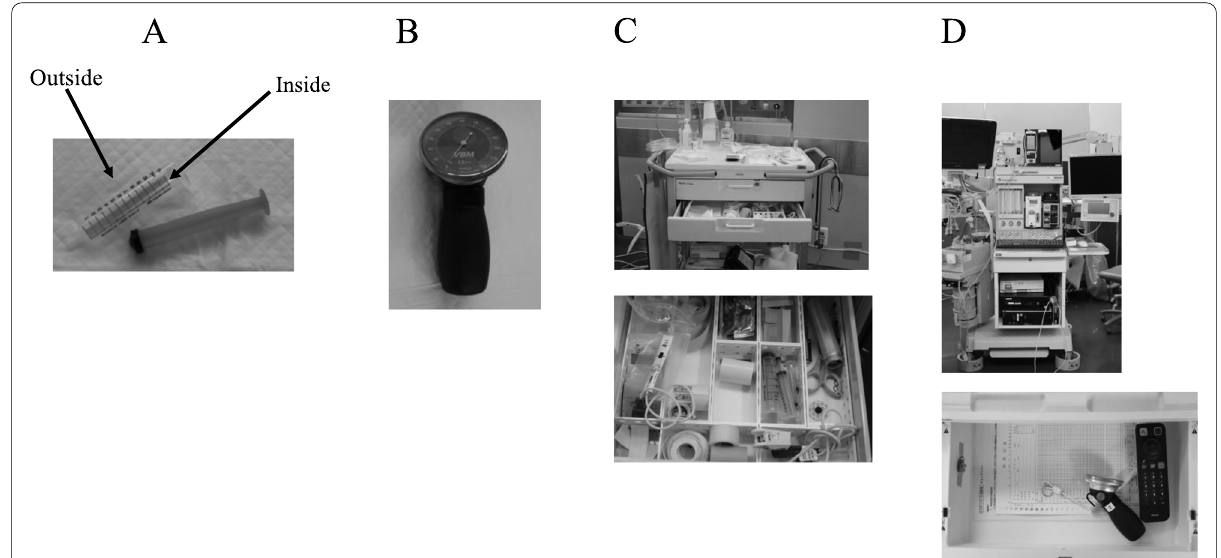
Fig. 1 Equipment-sampling sites. A cuff syringe, B cuff pressure gauge, C drawer where the cuff syringes are stored, D drawer of the anesthesia machine where the cuff pressure gauges are